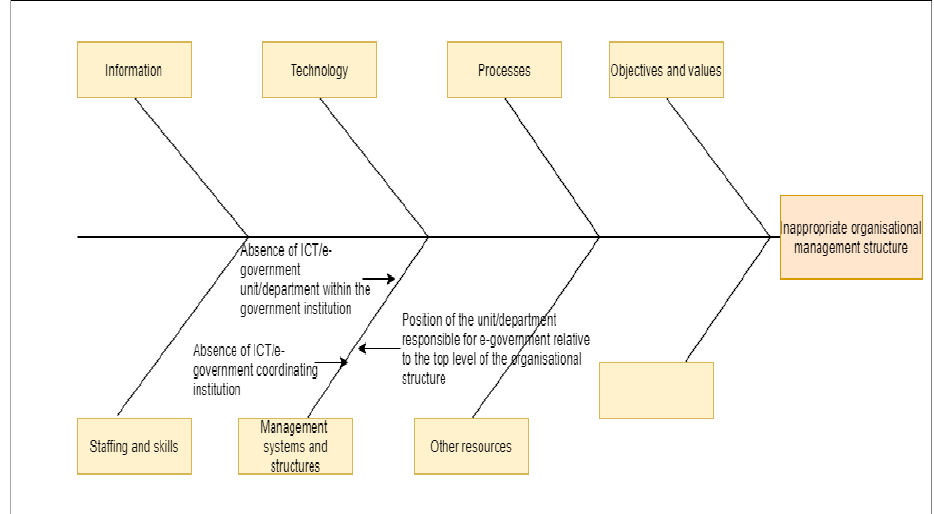
Figure 19: Inappropriate organisational management